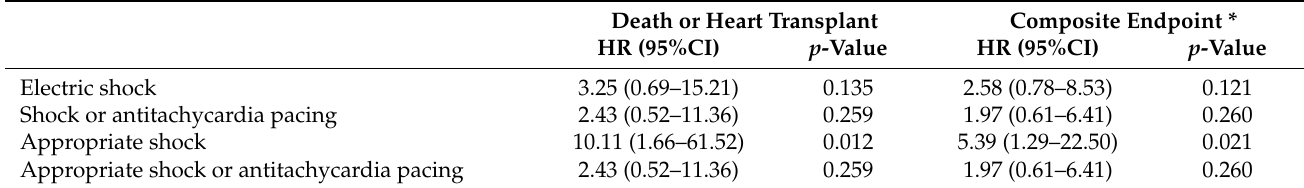
Table 3. Device-delivered electric shock and clinical events.